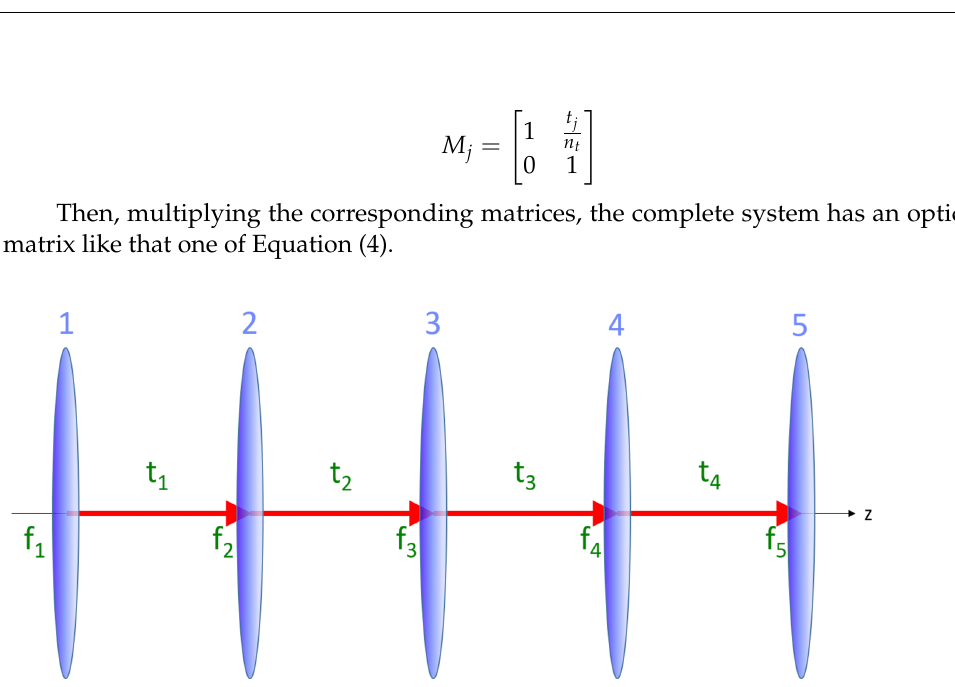
Figure 1. Simplified scheme for the five lenses system. f i is the focal distance of each lens, and t i the distances between two